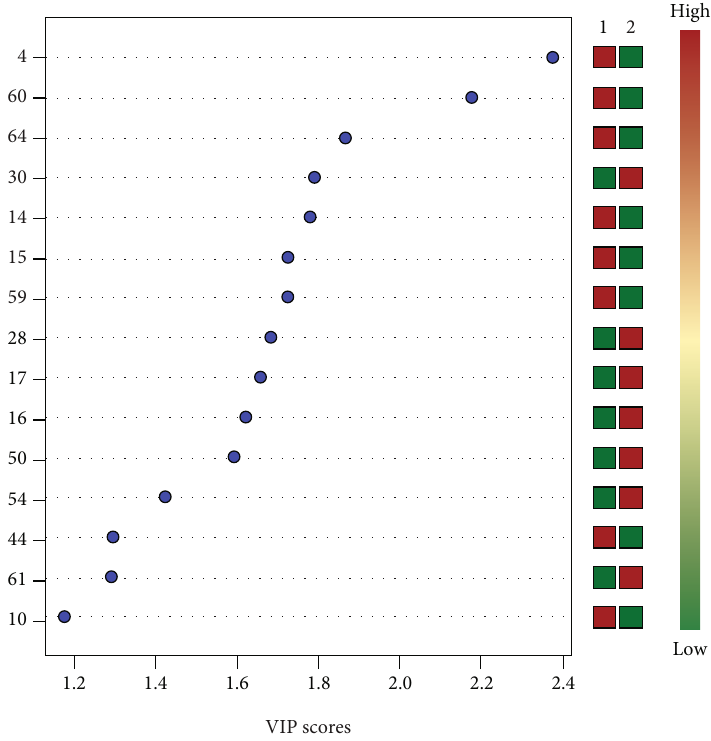
Figure 1: E ff ect of chronic periodontal disease on the distribution of VIP scores after the metabolome of in fl ammatory exudate present in the crevicular fl uid of old adults patients with periodontal disease. Separation of periodontitis (1-red) and healthy (2-green) groups according to metabolite pro fi le. Numbers 1 and 2 represent the healthy and periodontitis groups, respectively. The concentration of metabolites is represented by the color gradient between green (less concentrated) and red (more concentrated). To the left of the table are the metabolite IDs, identi fi ed in Table 3.